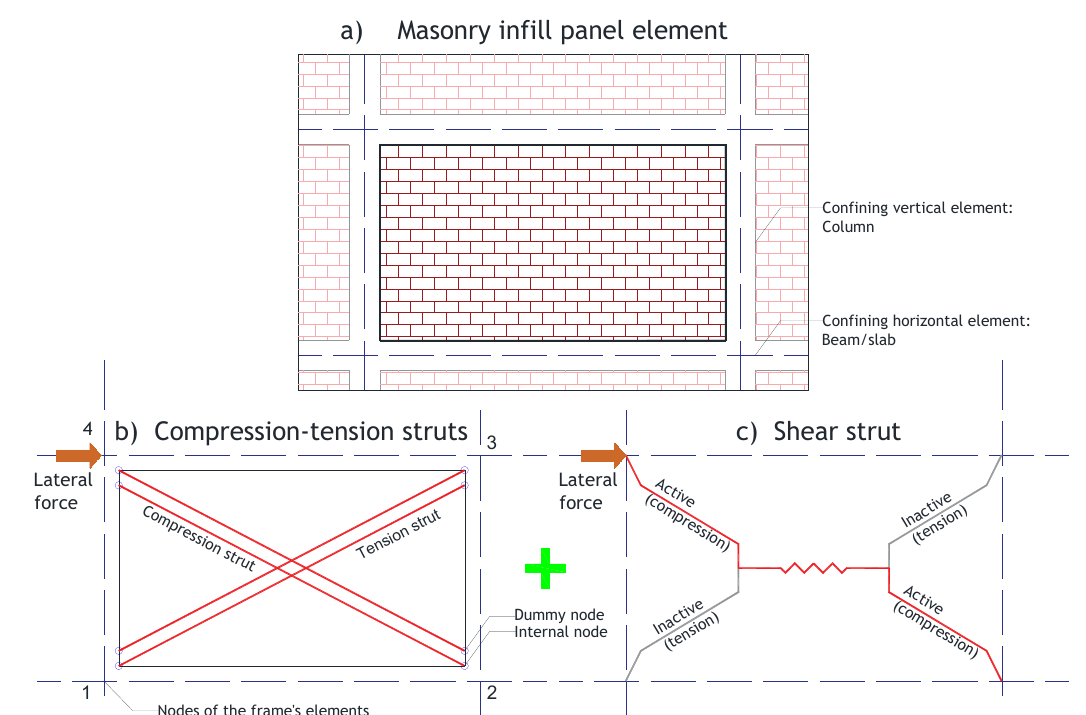
Figure 3. Confined masonry model ( a ) masonry infill panel and frame scheme, ( b ) compression-tension struts and ( c ) shear strut. Adapted from [27,28].